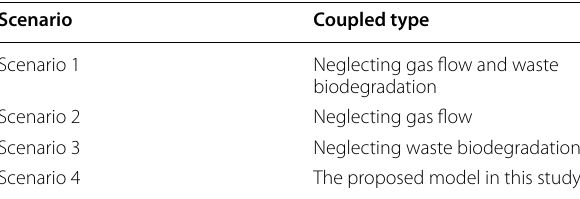
Table 5 Summary of leachate recirculation scenarios